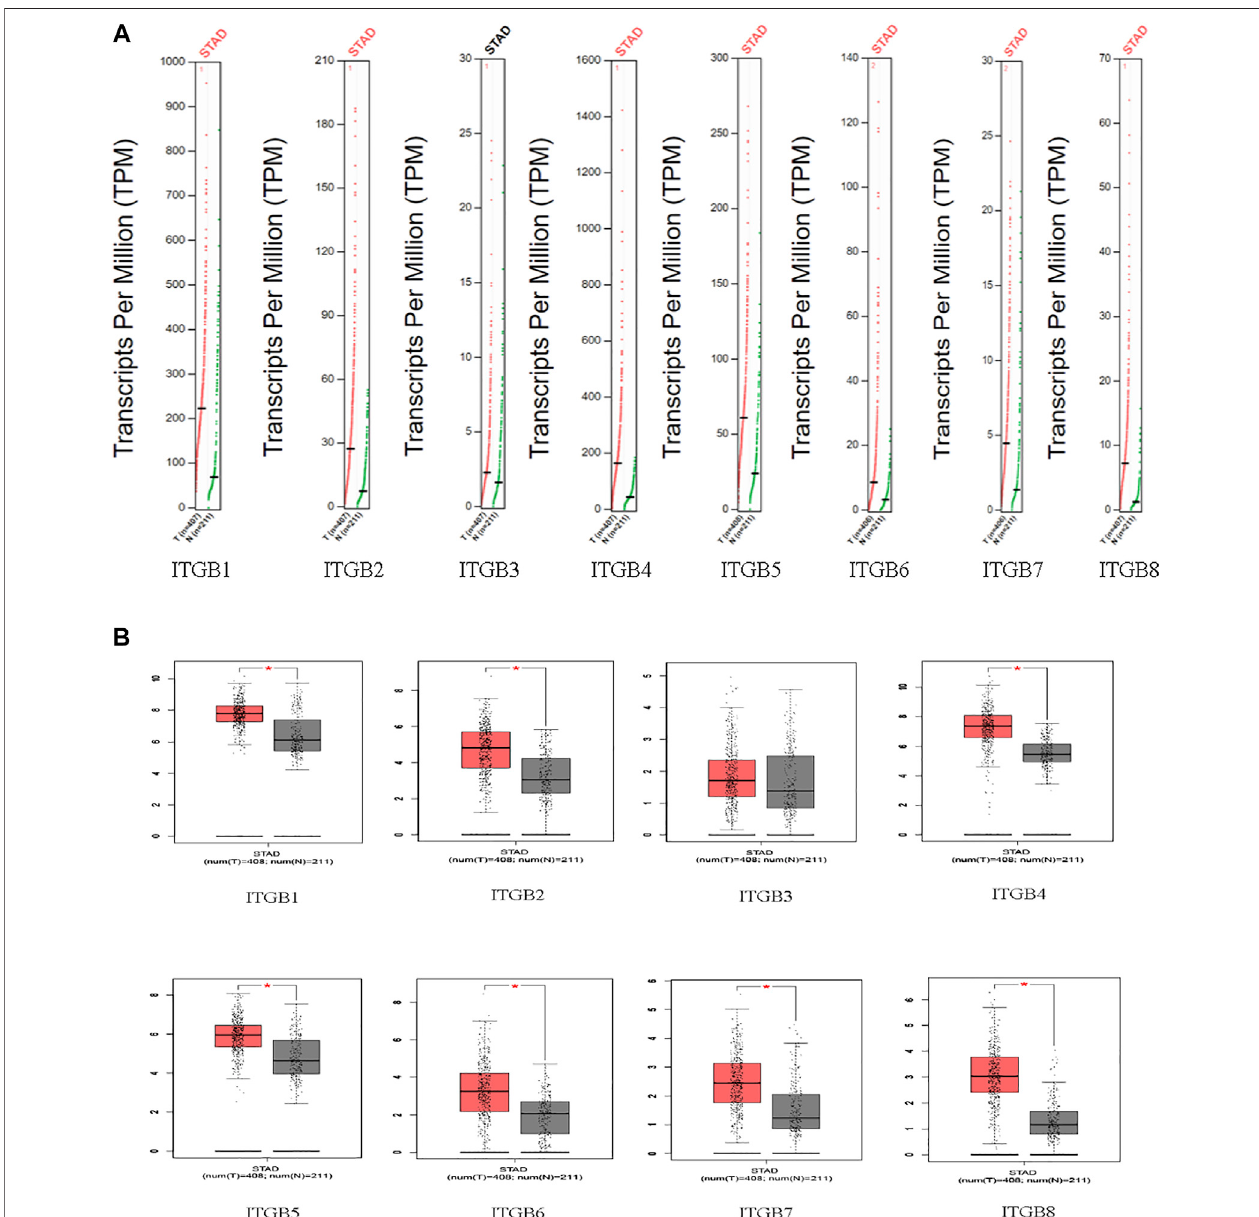
FIGURE 1 | The expression of ITGBs in GC [ (A) scatter diagram; (B) box plot] (GEPIA).